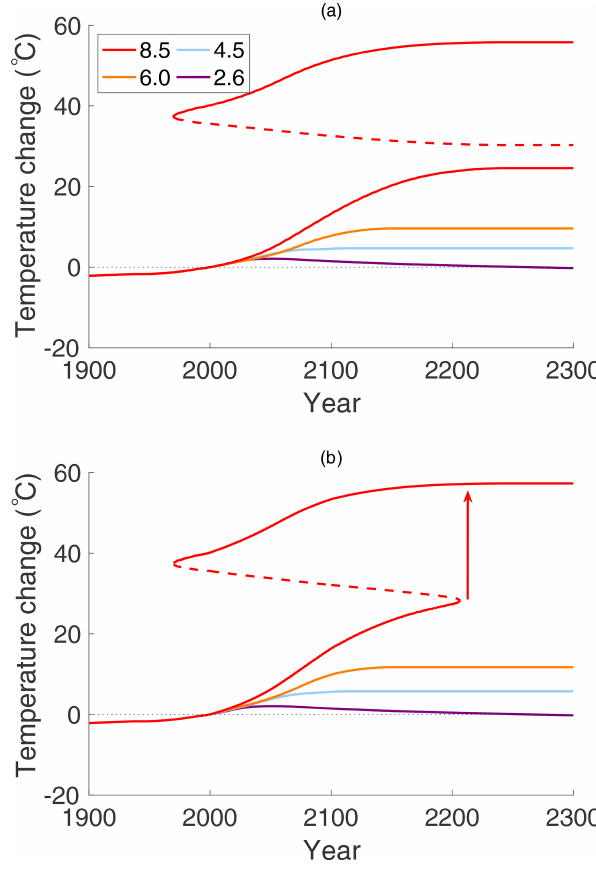
Figure 10. Antarctic surface temperature change projected to year 2300, relative to year 2000 temperature of − 32 . 78 ◦ C; (a) on each of the four RCPs with constant F O = 14Wm − 2 and (b) with in- creasing ocean heat transport F O ; see text for details. The upward arrow indicates the transition to a warmer equilibrium climate state after the saddle-node